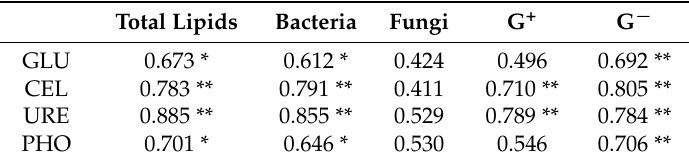
Table 6. Correlation coefficients between soil microbial community and enzyme activity in the mineral